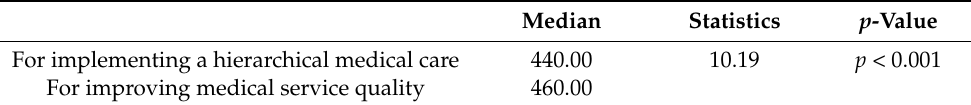
Table 7. Wilcoxon sign-rank test of the WTP for the outpatient copayment ( n = 913).